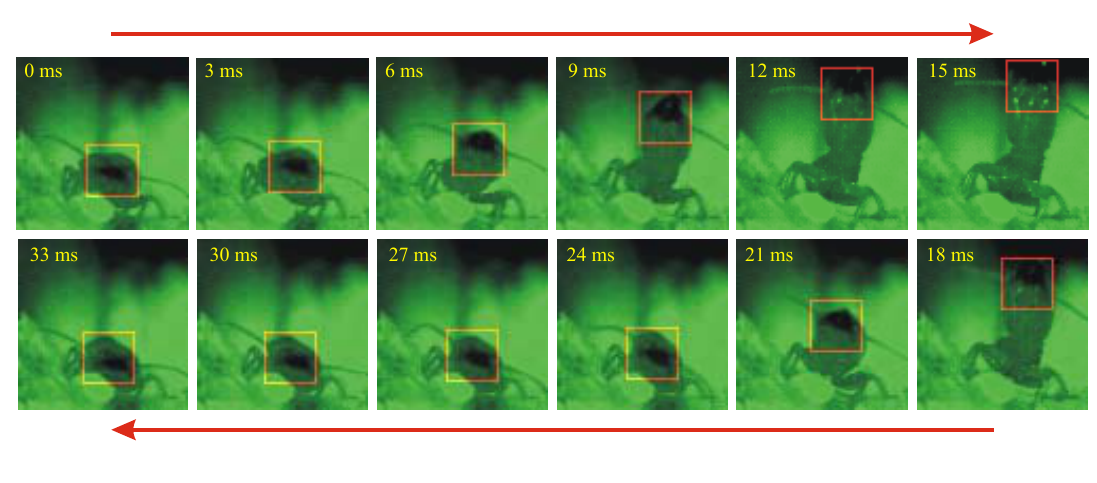
Figure 1. Tracking image pattern (24  24 pixels) on a termite head in a 33-ms head- banging period.